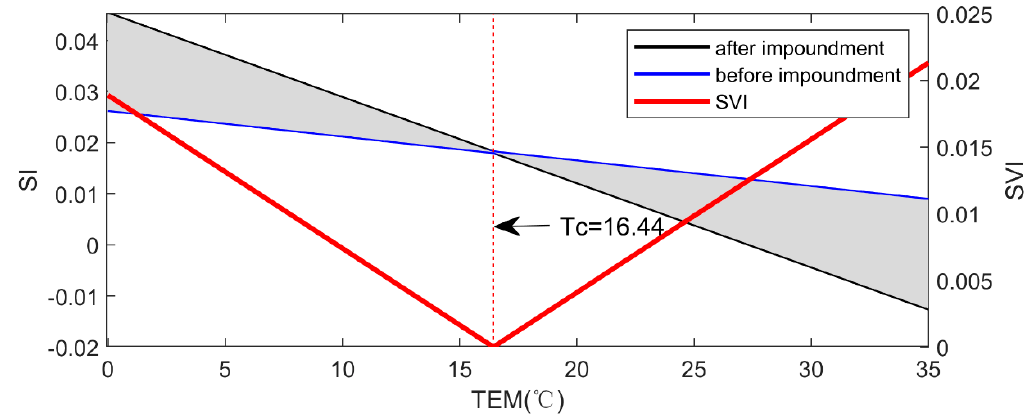
Figure 10. The sensitivity index (SI) and sensitivity variation index (SVI) for the NDVI–temperature response in 0–10 km zone (PRE = 100 mm).